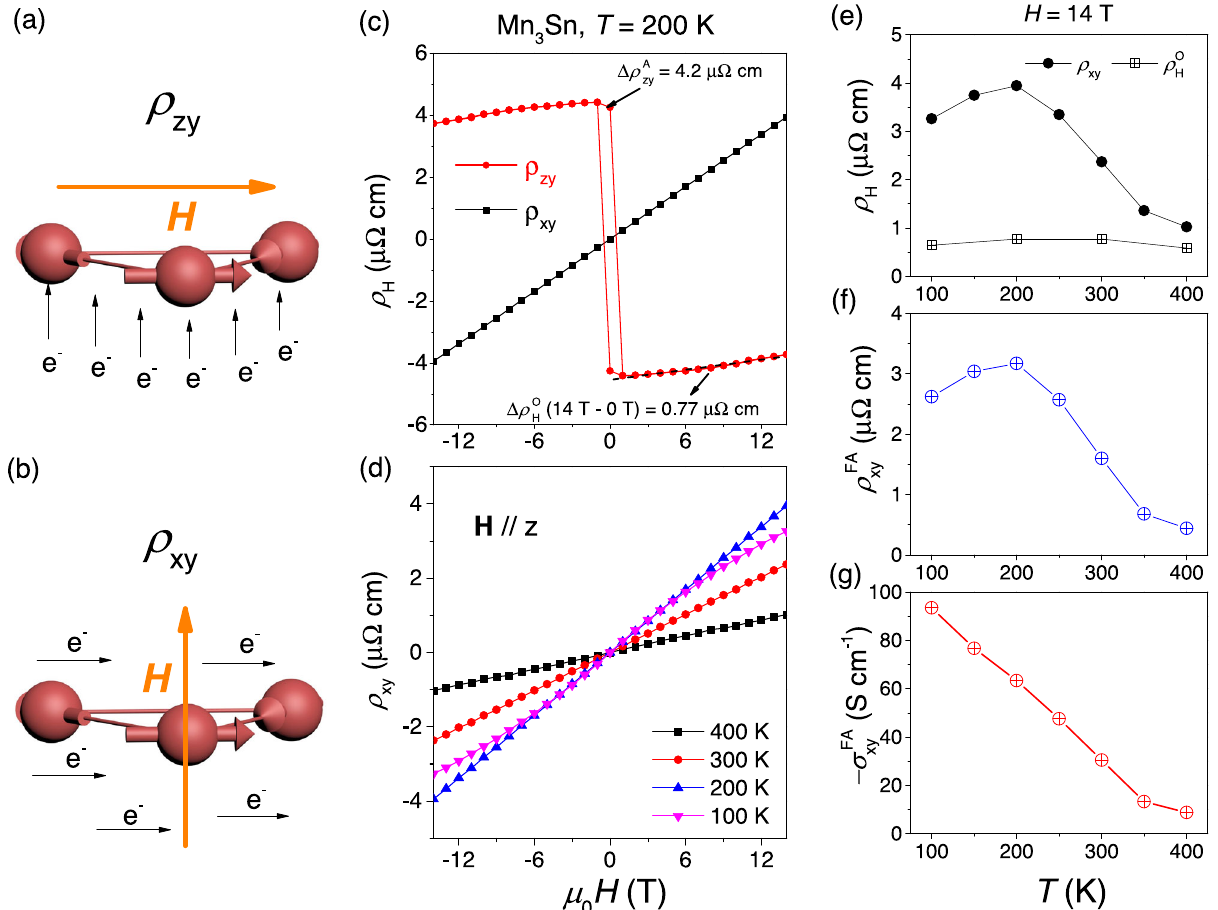
Fig.1|FieldinducedanomalousHalleffect.a , b DifferentHallcon fi gurations. ρ zy , ordinary Hall effect attains 3.9 μΩ cm at 14 T, exceeding ρ O H by far. d Field depen- the out-of-plane Hall con fi guration with the fi eld along x axis. ρ xy , the in-plane Hall dence of ρ xy with temperature varying from 100 to 400 K. e Temperature con fi guration with the fi eld along z axis. c Comparison of out-of-plane ( ρ zy ) and in- plane ( ρ xy ) Hall responses. ρ zy consists of two parts, the anomalous Hall resistivity μΩ cmat0T,andtheordinaryHallresistivity ρ O ρ A zy withaspontaneousvalueof4.2 H with avalue of 0.77 μΩ cm when the fi eldissweptfrom 14T to 0T. ρ xy , looking like